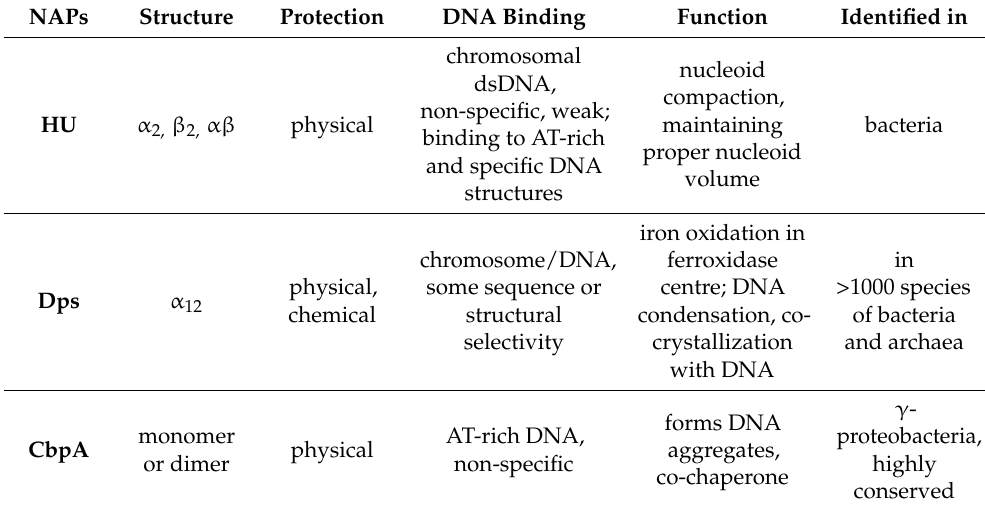
Table 1. Characteristics of bacterial DNA protective NAPs. NAPs Structure Protection DNA Binding Function Identified in